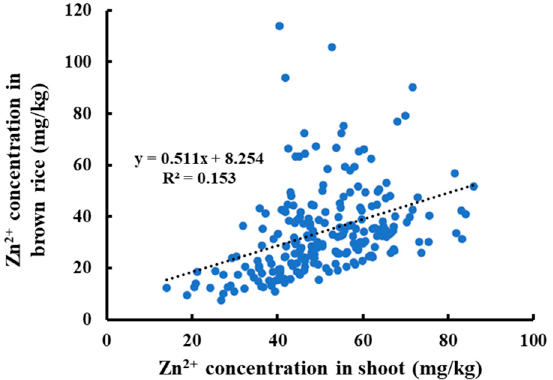
Figure 2. The relationship between Zn 2+ concentration in shoots at the seedling stage and in grains at the mature stage in the DC1 population.